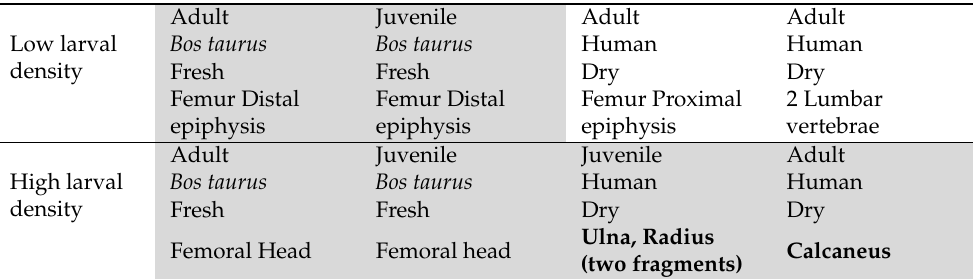
Table 1. Distribution of the bones according to the initial density of D. maculatus